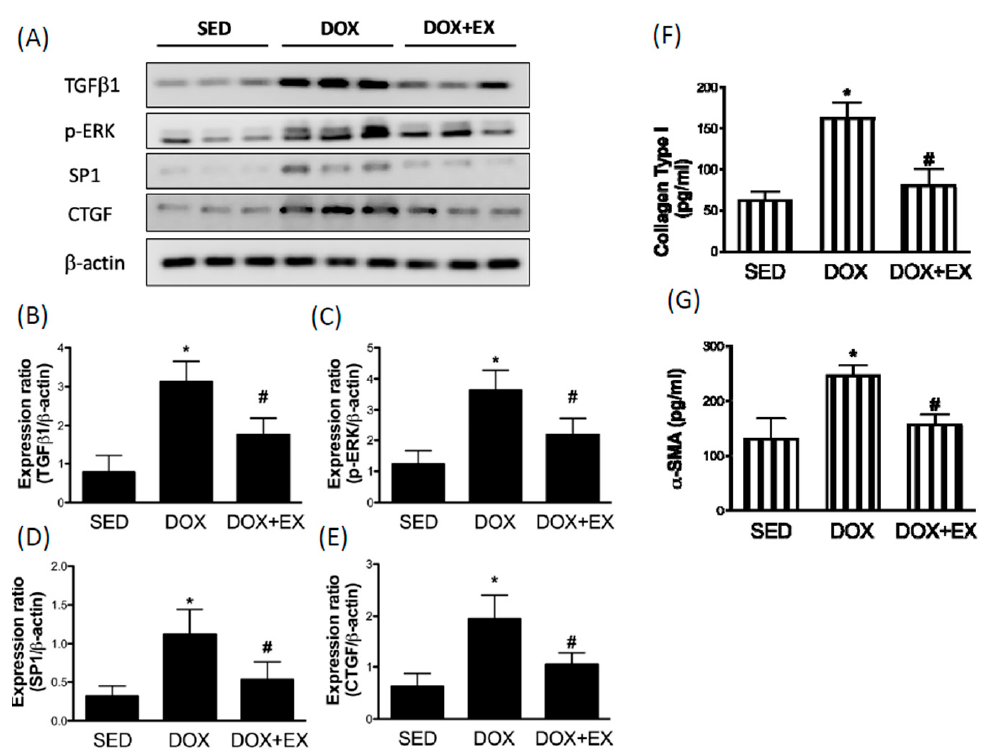
Figure 2. The effect of treadmill exercise on the DOX-driven upregulation of fibrosis factors Representatives of Western blot ( A ) and the densitometric analysis of TGF- β 1 ( B ), phosphorylated ERK ( C ), Sp1 ( D ), and CTGF ( E ). The collagen type I ( F ) and α -SMA ( G ) were tested by ELISA. * p <0.05 compared to the SED group. # p <0.05 compared to the DOX group. Detailed information about Figure 2A can be found at Figure S2.